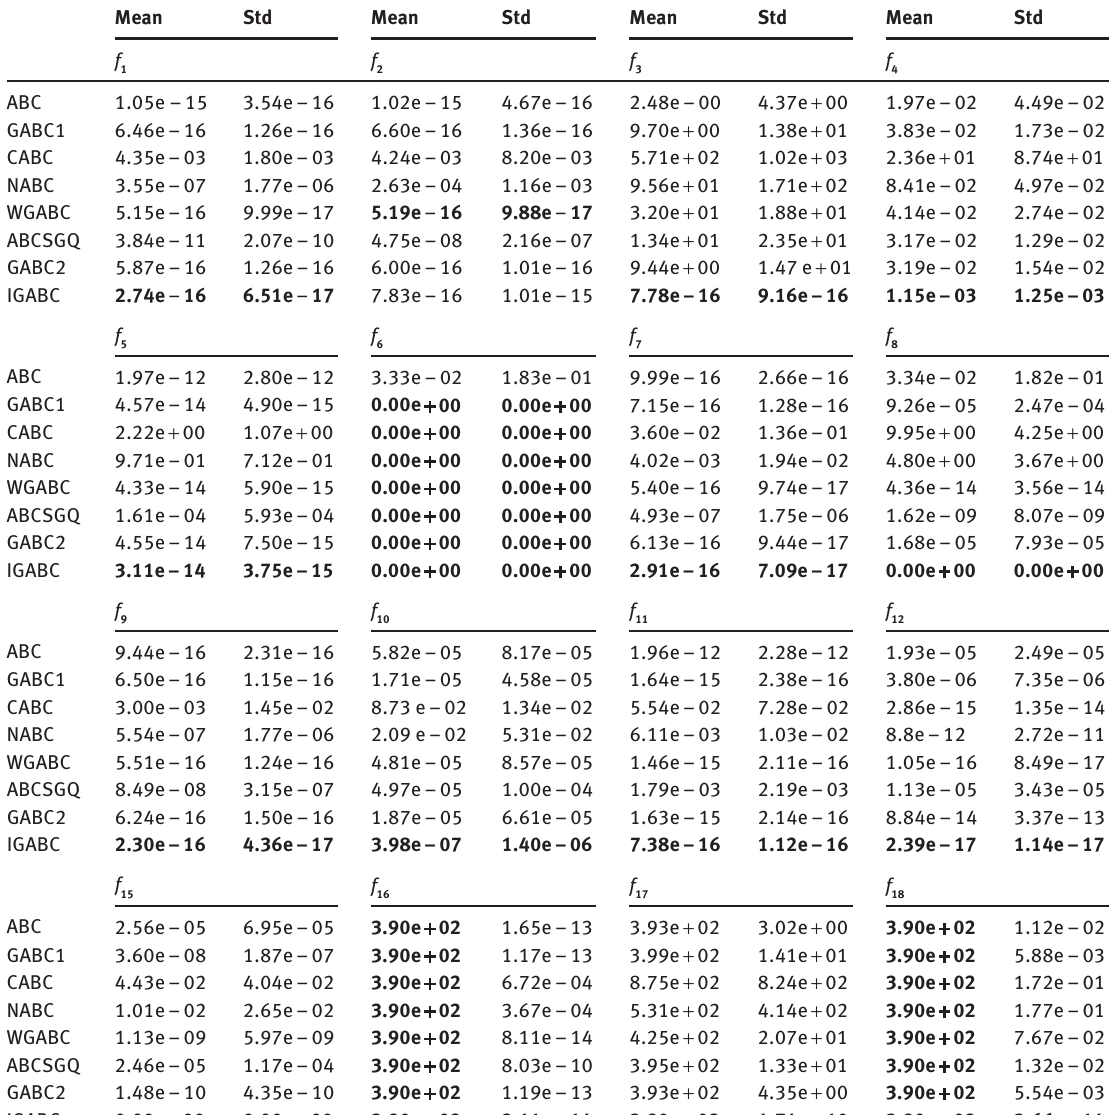
Table 2: Comparison of the Test Results of Eight Algorithms ( D =